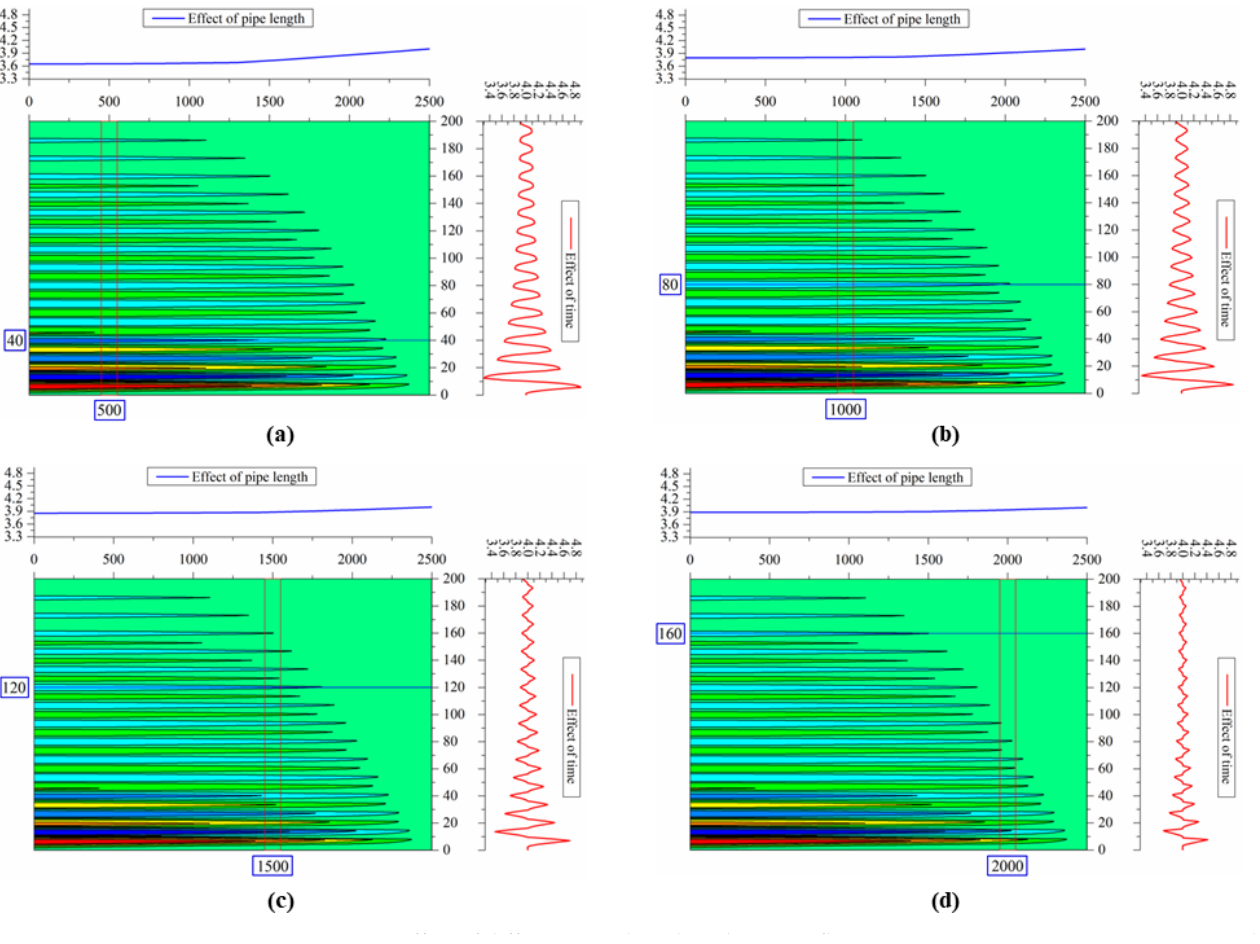
Figure 11. Effect of different pipe length and time on fluctuating pressure in pipe: ( a ) represents the pressure change chart in a 500 m section at 40 s; ( b ) represents the pressure change chart in a 1000 m section at 80 s; ( c ) represents the pressure change chart in a 1500 m section at 120 s; ( d ) represents the pressure change chart in a 2000 m section at 160 s.